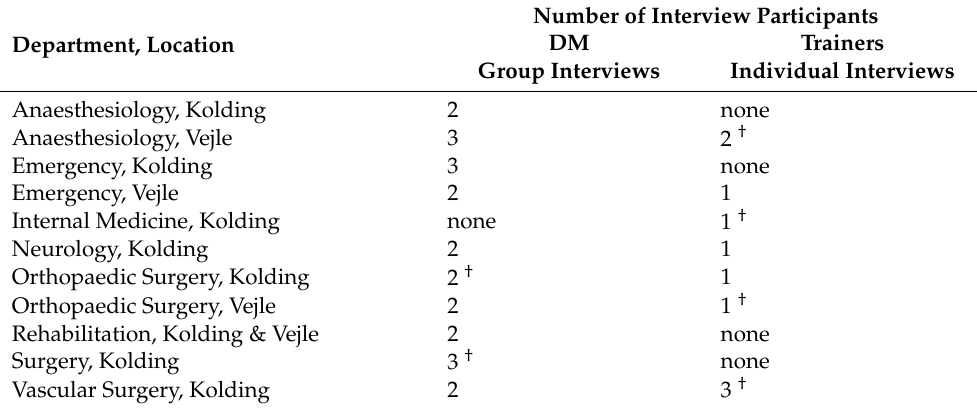
Table 1. Number of interview participants from the included